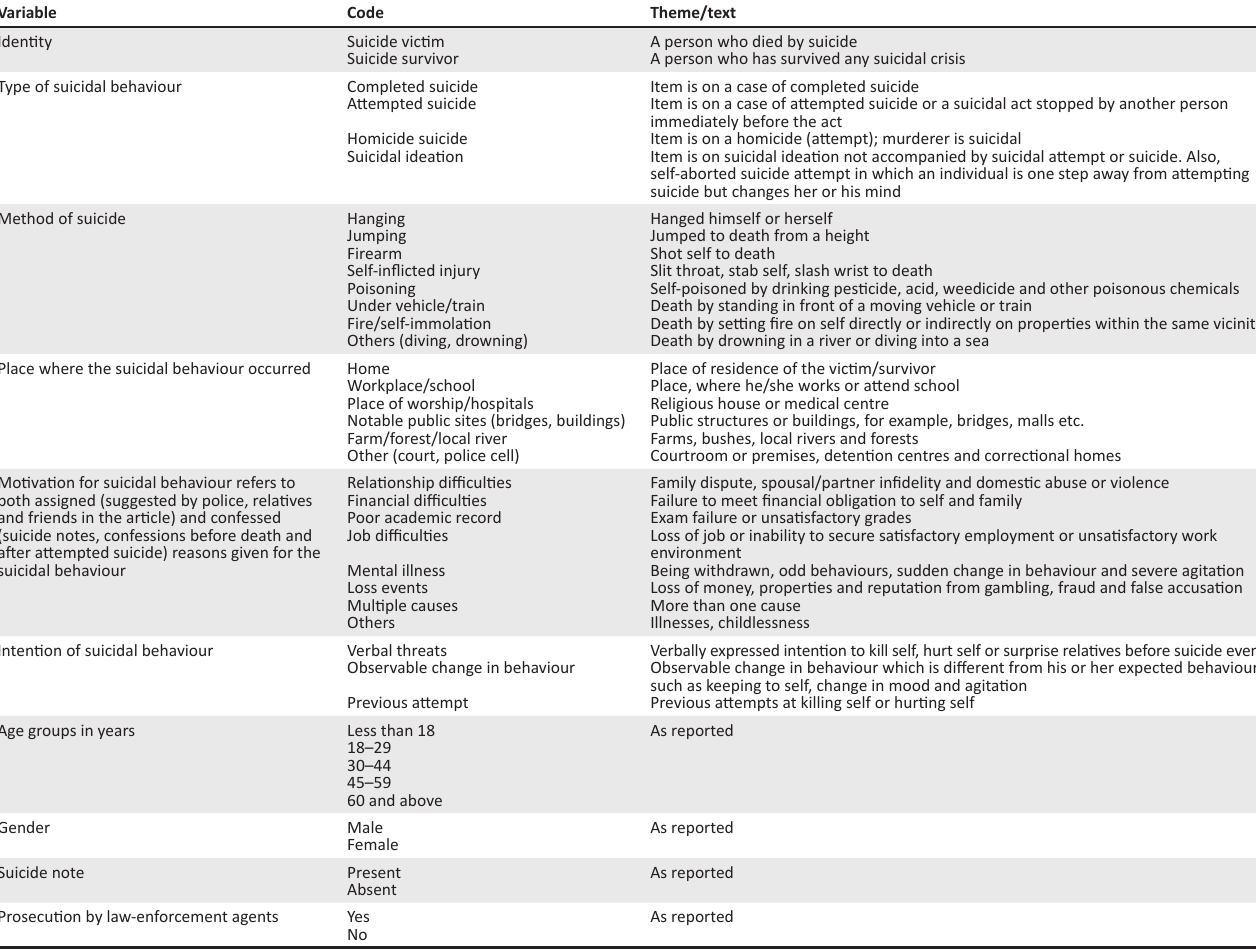
TABLE 1: Codebook for the abstracted data. Variable